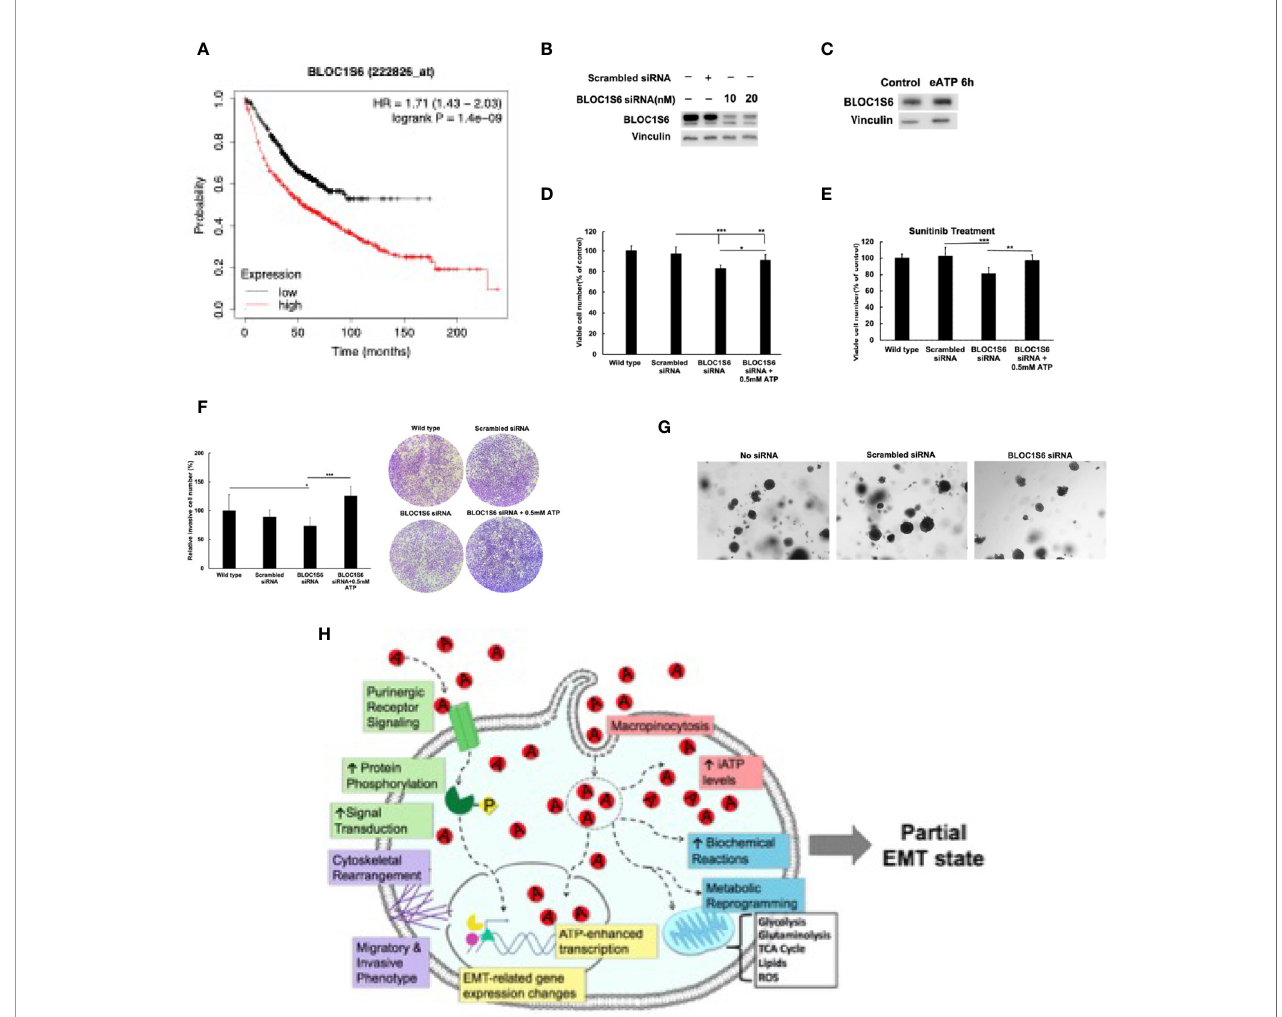
FIGURE 8 | BLOC1S6 gene is involved in the eATP induced proliferation, drug resistance invasion and colony formation in A549 cells. BLOC1S6 gene was knocked down or overexpressed in A549 cells. BLOC1S6 protein levels in these cells were measured by western blots. The KD A549 cells were tested in various assays to assess its potential roles in EMT and CSC formation compared with regular A549 cells. (A) The inverse proportional relationship between BLOC1S6 mRNA level and survival of lung cancer patients. Kaplan-Meier plots online tool (https://kmplot.com/analysis/) was used to analyze the relationship between Bloc1s6 genes and the overall survival rate of lung cancer. (B) Protein expression levels of BLOC1S6 under different siRNA treatment conditions. (C) Protein expression levels of BLOC1S6 with or without 0.5mM ATP treatment. (D) Cell viability/proliferation assay of KD cells with or without eATP treatment. (E) Cell viability/proliferation assay of KD cells treated with anticancer drug Sunitinib at 20 mM in the presence or absence of eATP. *P < 0.05, **P < 0.01,***P <.001. (F) Invasion assay of KD cells with or without eATP treatment. (G) Soft agar anchor-independent colony assay for testing KD cells ’ colony formation capability in KD and non-KD cells. Quanti fi cation of the assay can be found in Supplemental Figure S6 . (H) A hypothetical model for the mechanisms used by eATP to induce EMT. Detailed explanation for the model can be found in